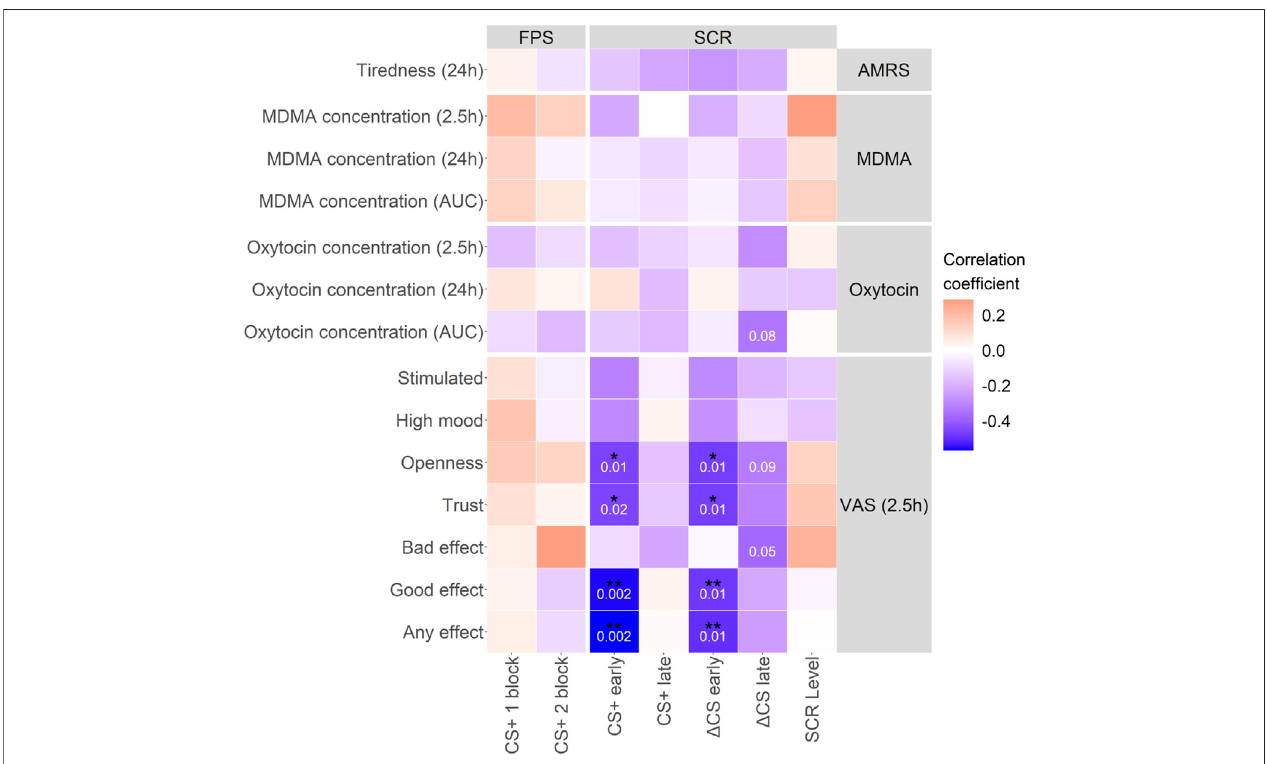
FIGURE 5 | MDMA characteristic effects, such as trust and openness, correlate with extinction recall. Correlation matrix between MDMA and oxytocin concentrations and subjective effects of MDMA with extinction recall parameters. Characteristic MDMA effects during extinction learning correlated with the CS+ and subsequently Δ CS in the early phase of extinction recall. Pearson correlation coef fi cient was used. p -values in white numbers. * p < 0.05; ** p < 0.01. Not corrected for multipletesting.CS+,conditionedfearstimulus;CS − ,conditionedsafetystimulus; Δ CS,CS+ – CS − ;AMRS,AdjectiveMoodRatingScale;VAS,visualanalogscale; FPS,fear-potentiatedstartle;SCR,skinconductanceresponse;MDMA,3,4-methylenedioxymethamphetamine.Concentrationsat2.5hweregeneratedasthemeanof the respective 2 and 3 h time points. Data is from MDMA sessions only.